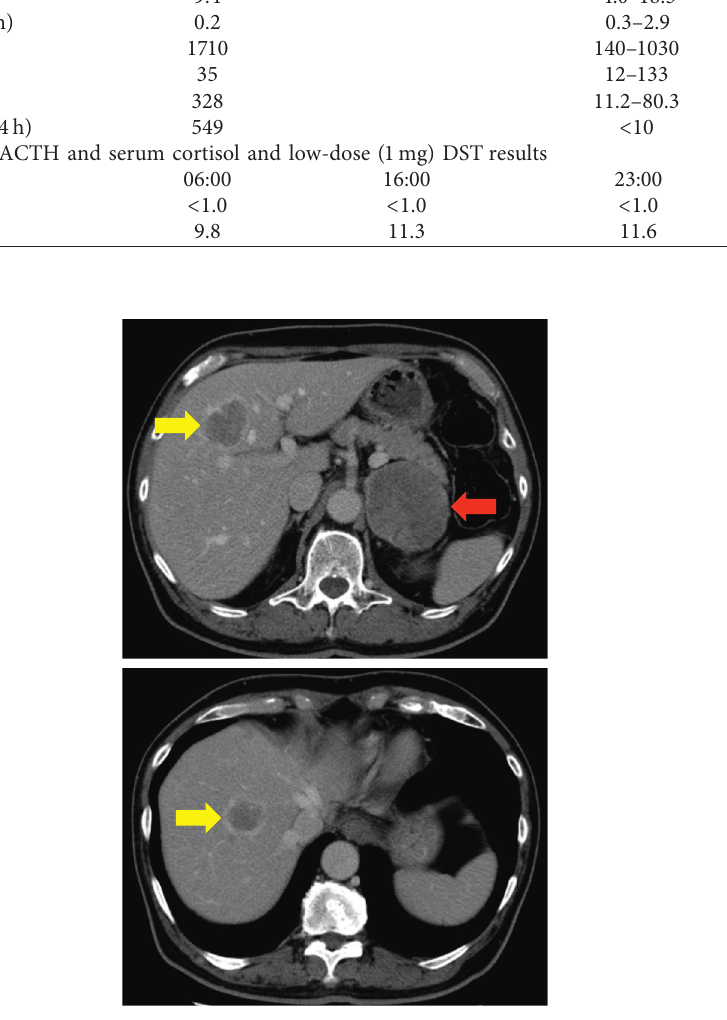
Figure 1: Abdominal computed tomography scan. The red arrow indicates the left adrenal tumor (diameter, 7cm). The yellow arrows indicate multiple liver tumors (diameter, ∼